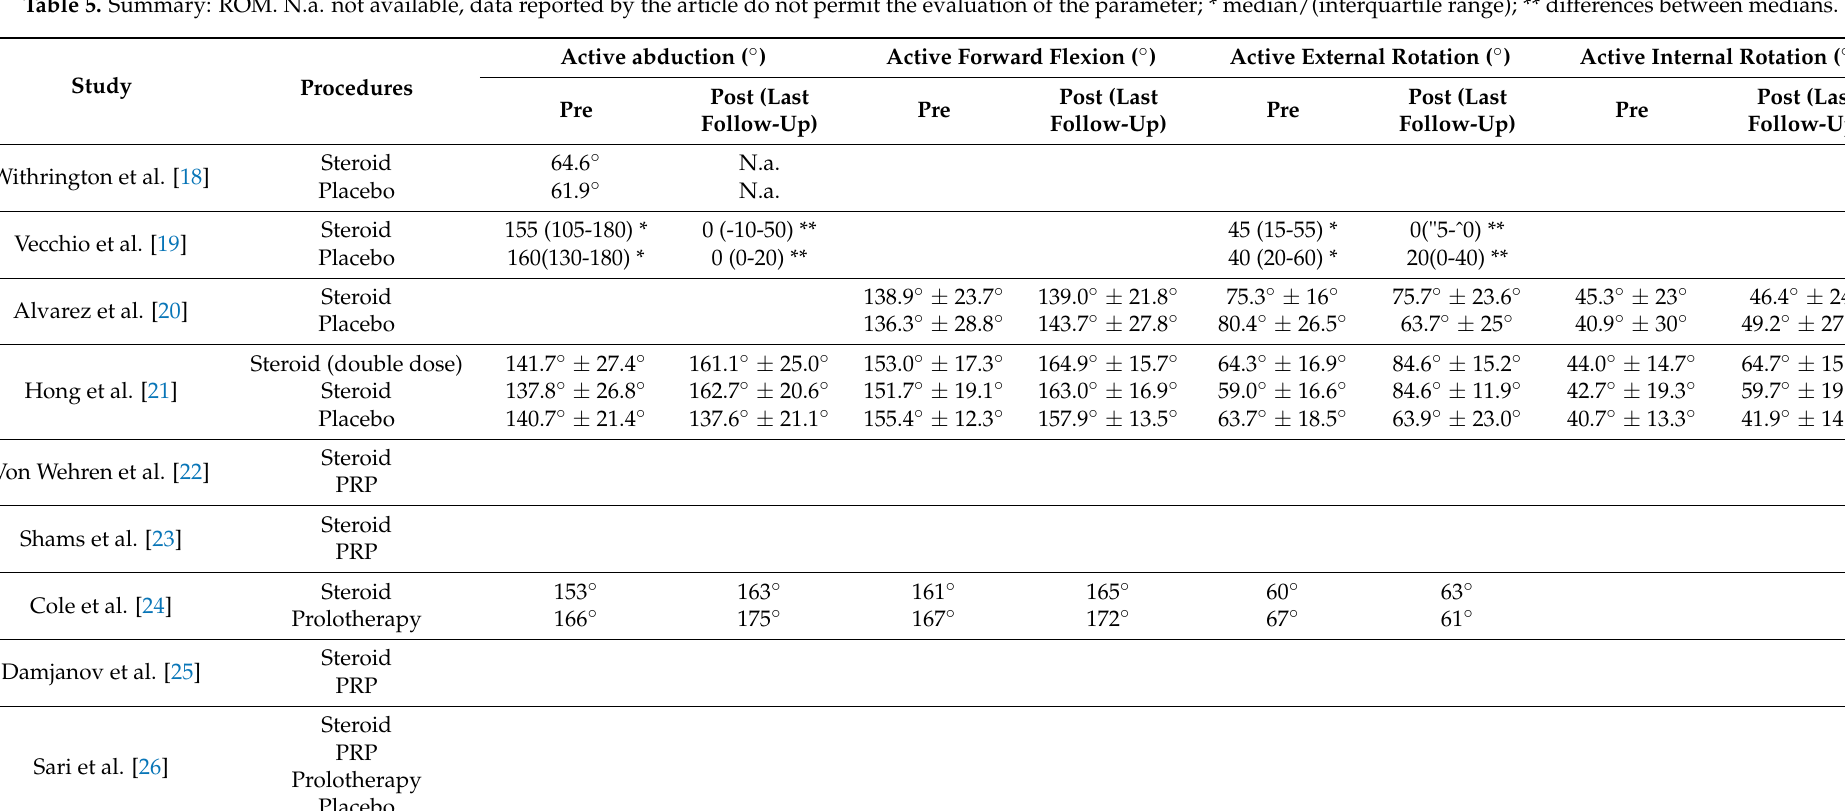
Table 5. Summary: ROM. N.a. not available, data reported by the article do not permit the evaluation of the parameter; * median/(interquartile range); ** differences between medians. Study Procedures Withrington et al.